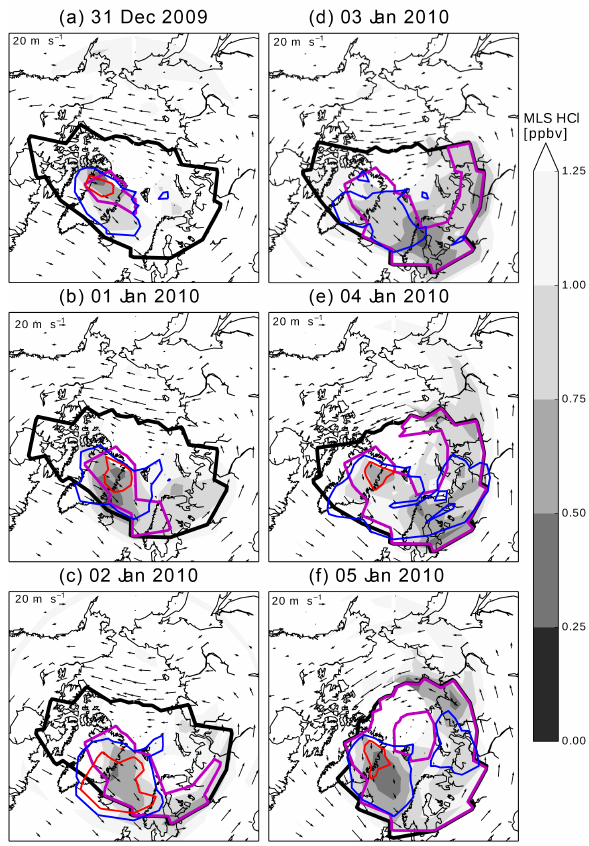
Figure 3. The meteorological situation over a 6-day period from 31 December 2009 to 5 January 2010 for the Arctic winter 2009/2010 on the 510K isentrope (approximately 22km). Arrows show the prevailing wind direction and speed. The vortex edge is calculated according to Nash et al. (1996) and shown in solid black. Solid magenta indicates regions of the vortex with air which has passed through a PSC. Blue and red contours show the particulate backscatter from CALIOP where blue represents the detection limit for CALIOP (3 × 10 − 5 km − 1 sr − 1 ) and red values are indicative of PSCs with a surface area density of more than 10 times the back- ground values (1 . 5 × 10 − 4 km − 1 sr − 1 ). Gray contours show HCl mixing ratios from